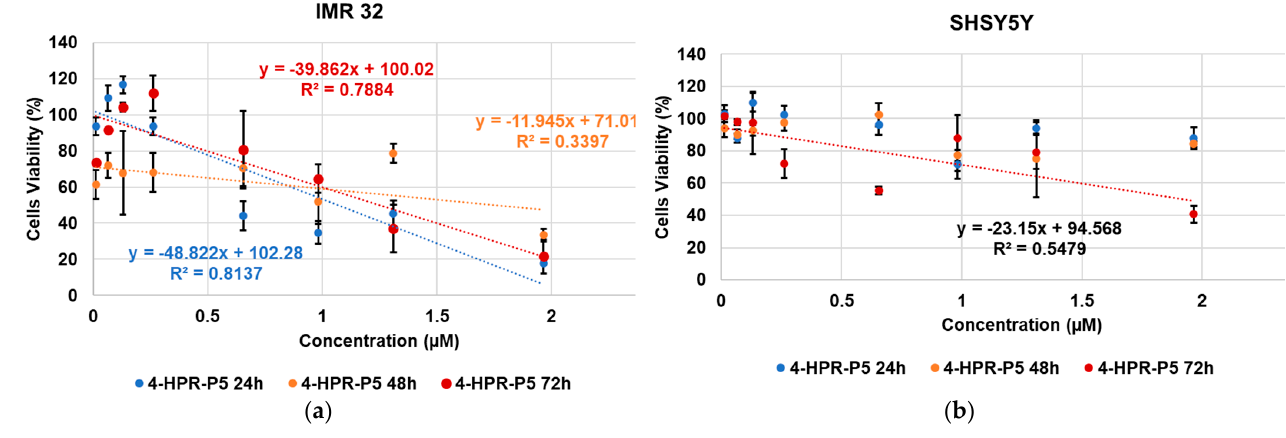
Figure 14. Dose-dependent cytotoxicity activity of 4-HPR-P5 NPs at 24 h (blue), 48 h (orange), and 72 h (red) in IMR-32 cells ( a ) and SH-SY5Y cells ( b ) in the range 0.013–1.96 µM. Table 3. IC50 of 4-HPR, P5, and 4-HPR-P5 NPs for IMR-32 and SH-SY5Y NB cells at 24, 48, and 72 h.